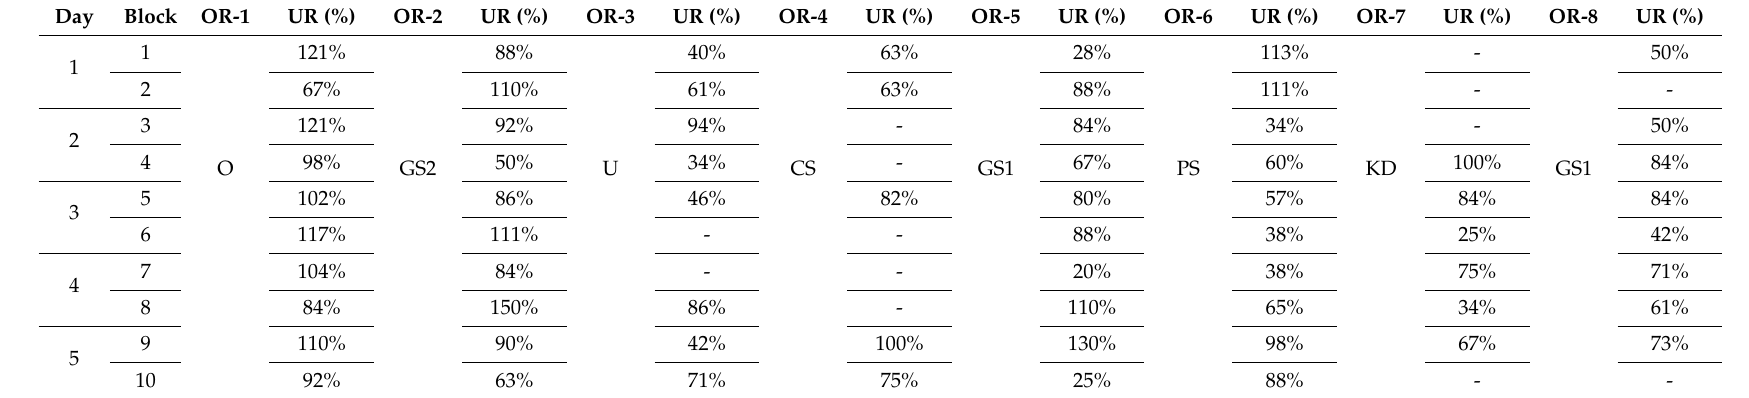
Table 7. Created schedule for Scenario 6 as a result of the constraint programming